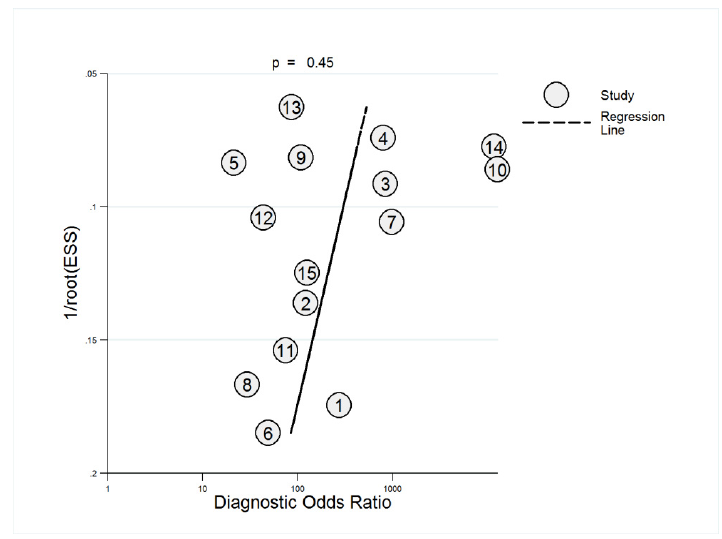
Figure 7. Plot of Deeks asymmetry test for publication bias.